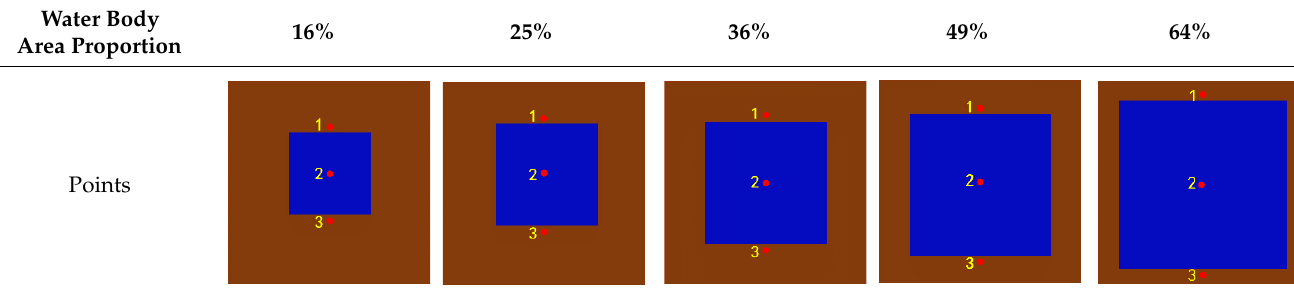
Figure 11. Distribution of temperature in cases 1, 5, and 6 at 14:00.